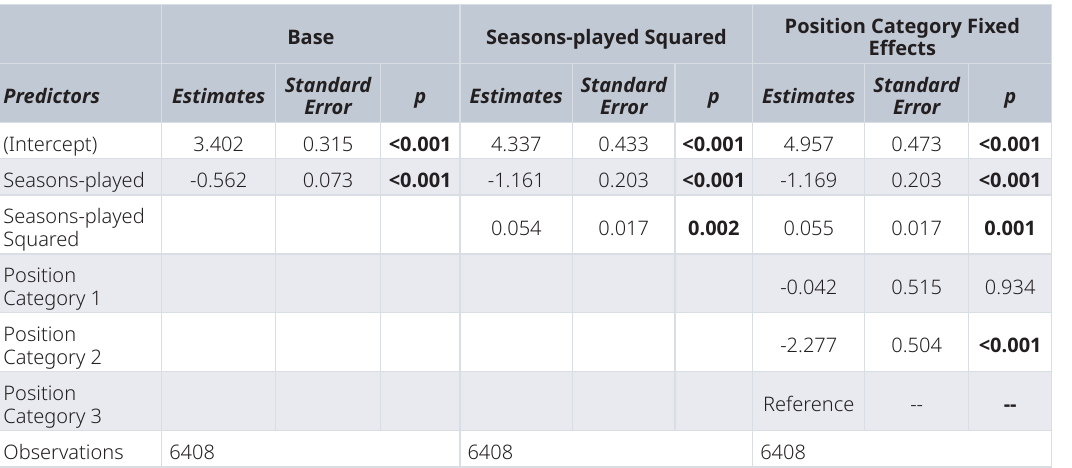
Table 2. Linear regression models predicting age-at-death Residuals among National Football League (NFL) players (1922–2018) N=6408.